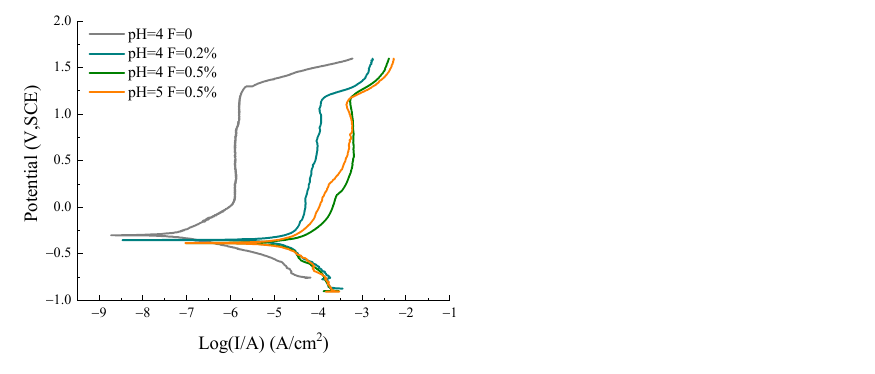
Figure 9. SLM TiNi sample polarization curve in ASS with different pH and F − concentration. Table 4. Potentiodynamic polarization corrosion parameters of SLM and wrought TiNi samples in 0.5% F − ASS at pH 4.